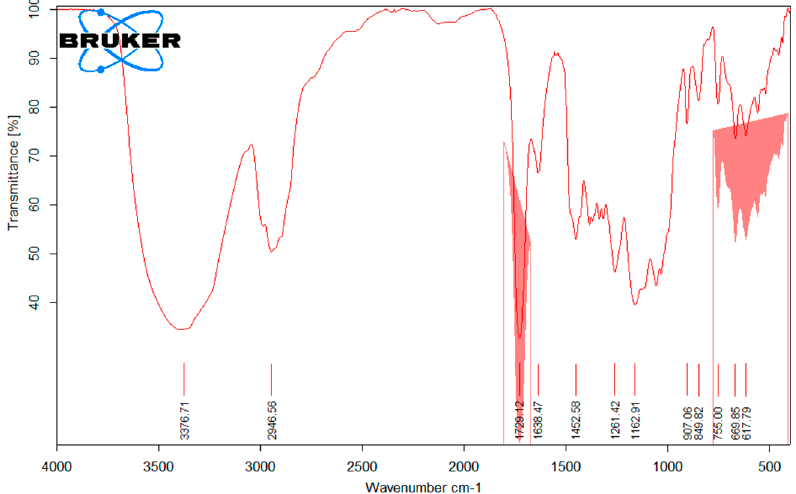
Figure 11. BNC-GMA-EGDMA MS = 0.6 FT–IR spectrum. GMA and EGDMA ester groups signal and cellulose reference signals in evidence.